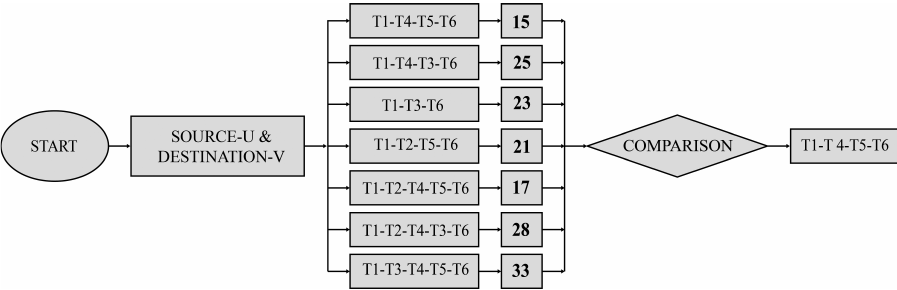
Fig. 3. Shortest path ¯nder process. Each of the steps calculates the least weighted path cost, after comparing each of the cost from Eqs. (1) –